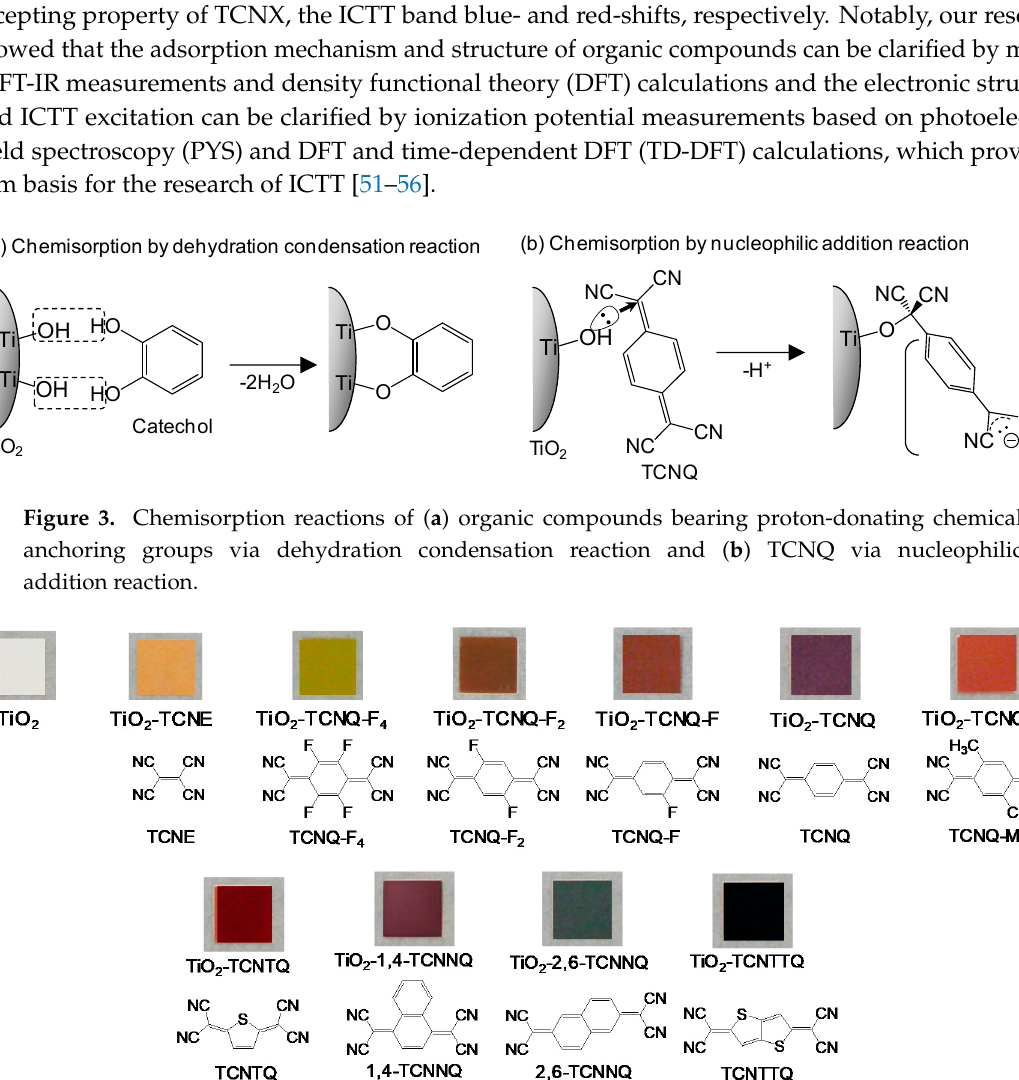
Table 2. Incident photon-to-current conversion efficiency (IPCE) maximum values reported for ICTT based photovoltaic conversion in organic-metal oxide complexes.